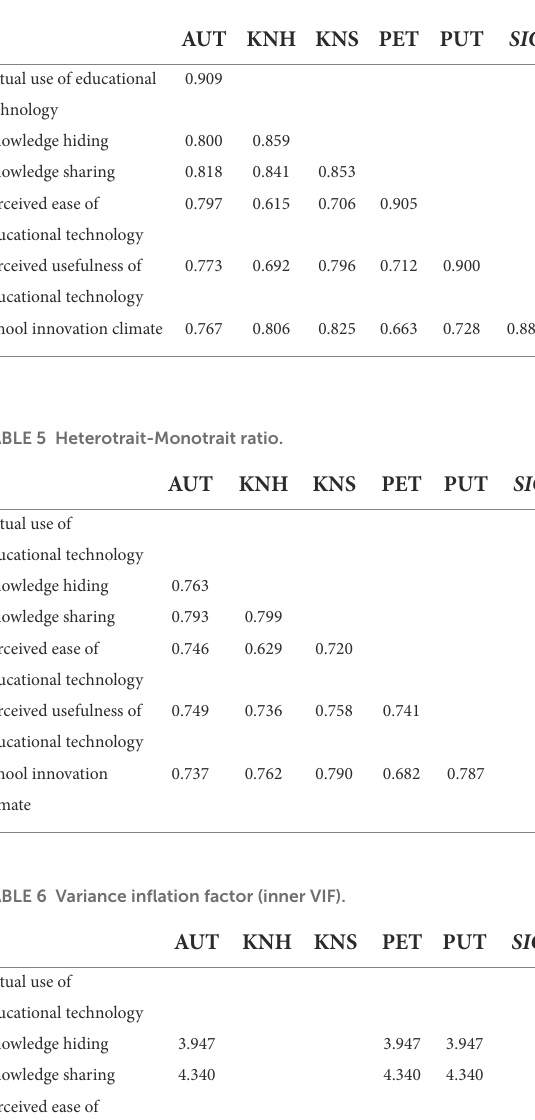
TABLE 4 Fornell and Larcker. TABLE 2 Outer loadings.